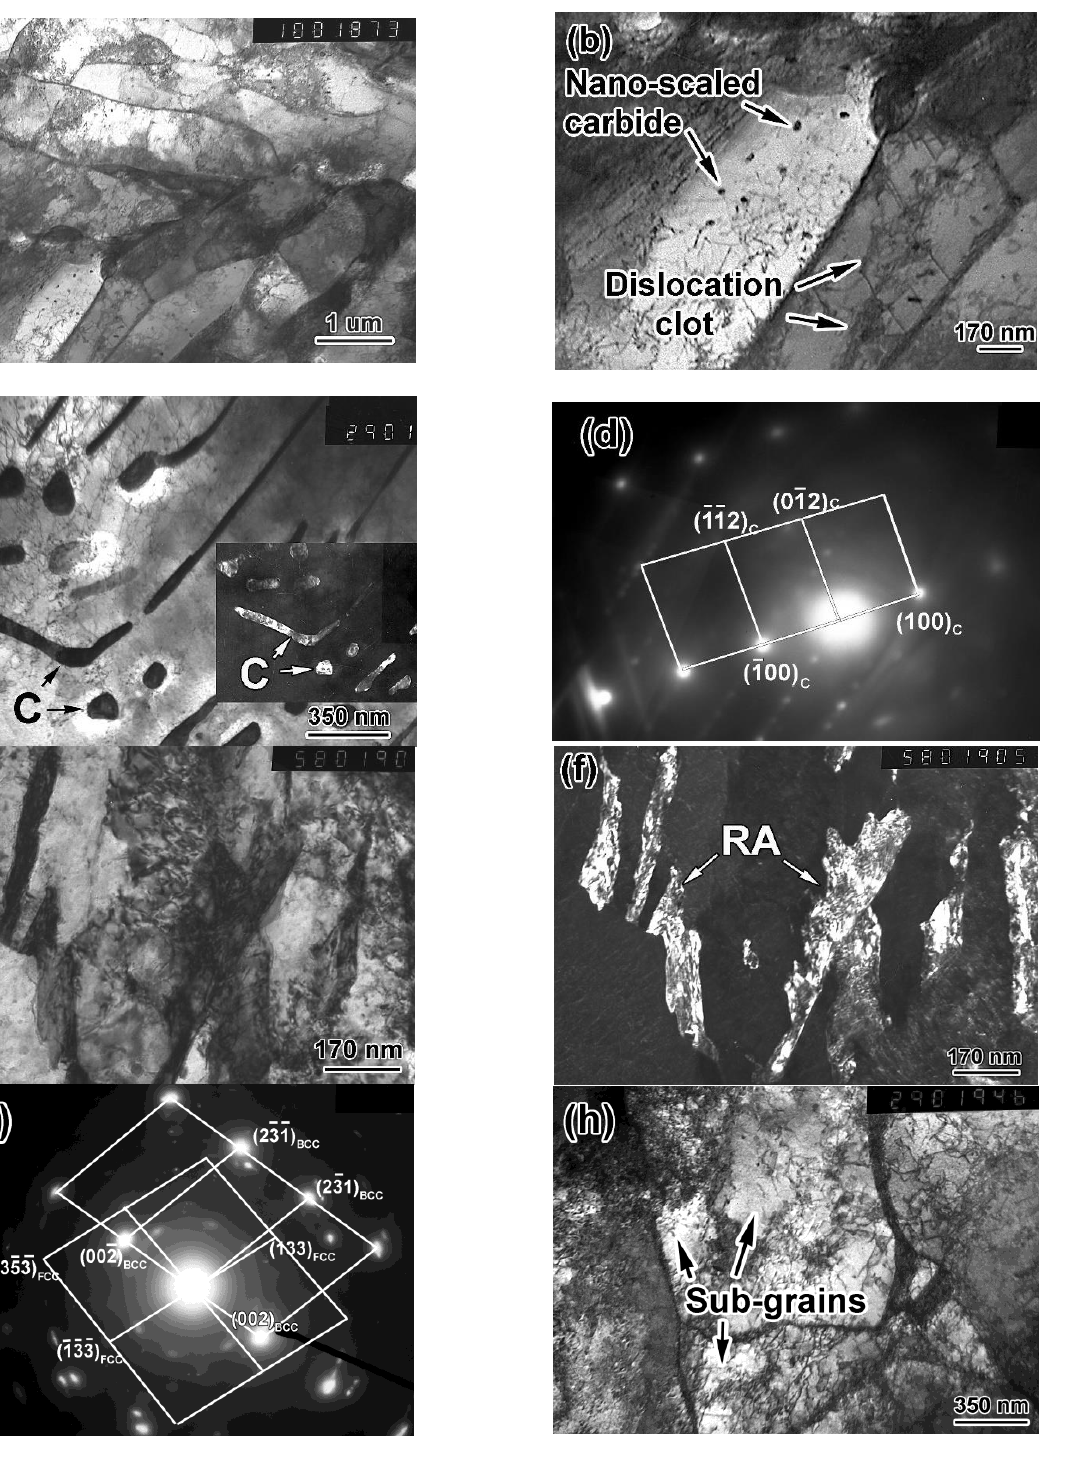
9 of 21 Figure 6. ( a ) XRD patterns of heat-treated specimens and ( b ) effect of austenitizing temperature on the volume fraction of RA and carbon content in RA. Figures 7 and 8 present the fine structures of heat-treated specimens. Figure 7a il- lustrates that the bainite in the specimen that was austenitized at 770 °C bainite consist- ed of elongated  -laths having a width of about 0.68 ± 0.17  m with occasional austenite interlayers. Dislocation clots and nano-scaled carbide particles were observed inside the laths (Figure 7b). Furthermore, the coarse plate-shaped (of 37.1 ± 8.0 nm width) and grain-shaped (of 112.8 ± 8.4 nm diameter) precipitates were observed between the ferrit- ic laths (Figure 7c). The dark field observation in a cementite reflex (insert to Figure 7b) and the selected area electron diffraction (SAED) pattern confirmed that the precipitates were carbides with an orthorhombic lattice, which is characteristic of the Fe